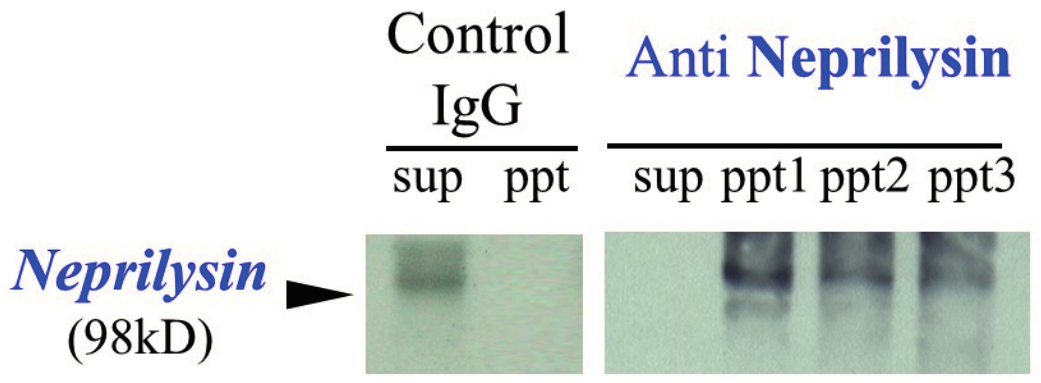
Figure 1. Western blotting of supernatants and precipitates following immunoprecipitation with anti-neprilysin or control